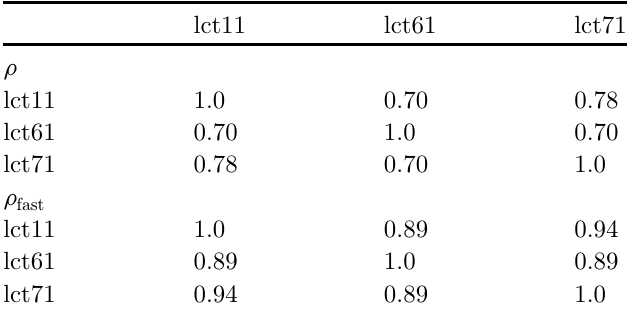
Table 1. Correlation coef fi cients ( k data) between lct11, lct61 and lct